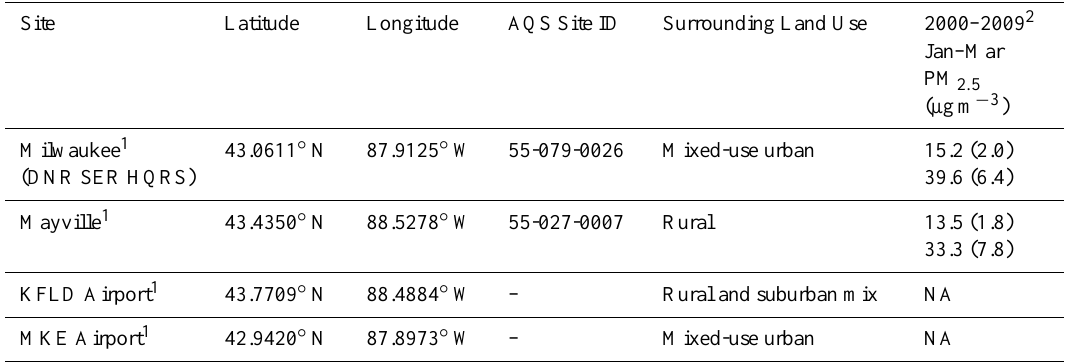
Table 2. Details of monitoring